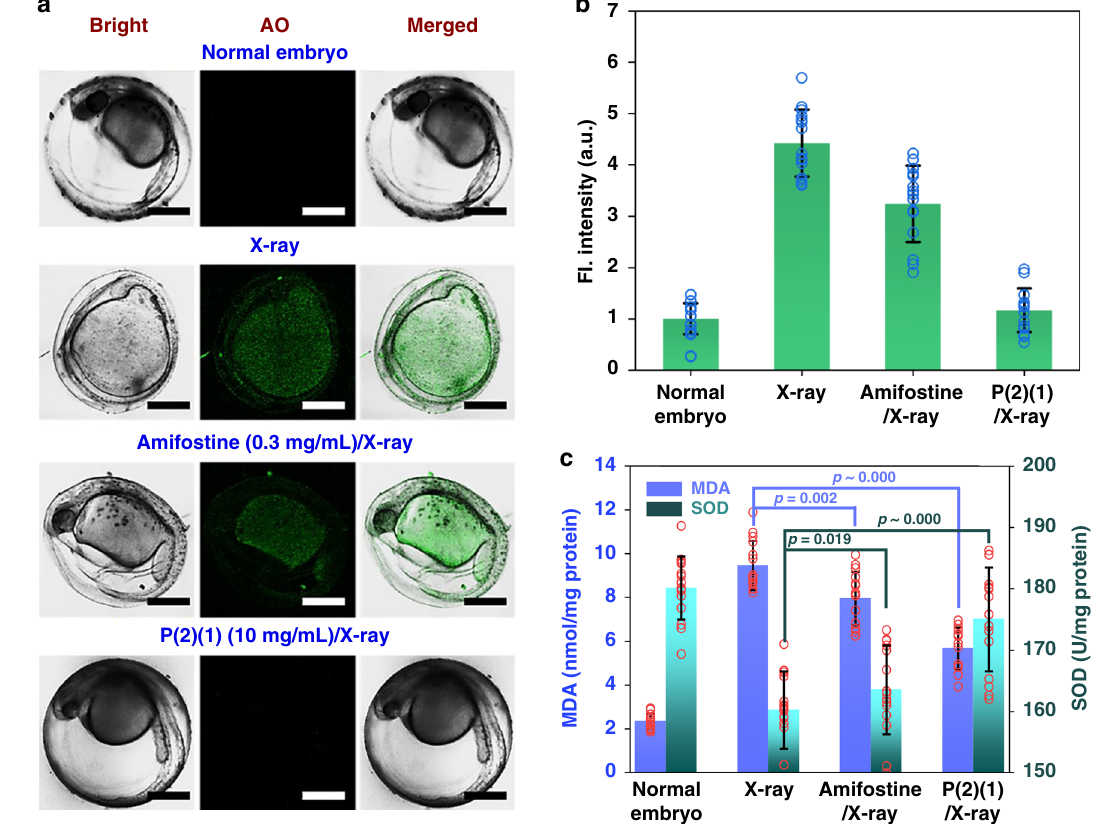
Fig. 6 In vivo experiments (zebra fi sh embryos) to test radioprotection ability of different compounds. a LSCM images of zebra fi sh embryos (60 hpf) under different conditions. Scale bar = 300 μ m. b Fluorescence intensity (AO) in zebra fi sh embryos under different conditions. Data are presented as mean values ± SD ( n = 15 independent animals). c SOD and MDA levels in the zebra fi sh embryos under different conditions. Data are presented as mean values ± SD ( n = 15 independent animals). Statistical analyses of results were performed by Student ’ s t -test for independent samples (one-side), there was no adjustment made for multiple comparisons. Source data are provided as a Source Data fi